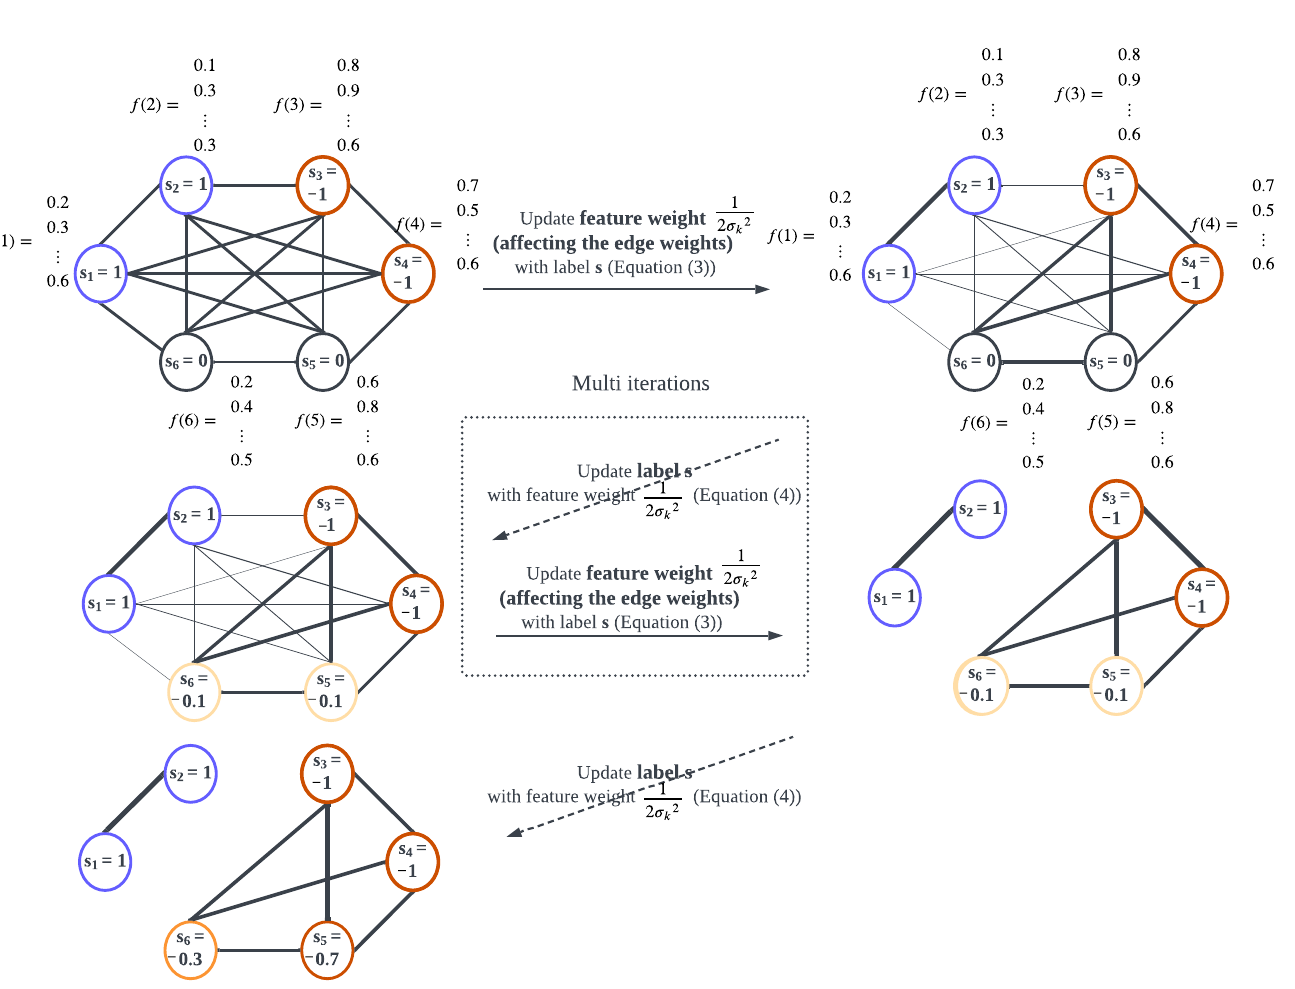
Figure 2. Graph-based feature weight optimisation and classification (schematic diagram), where the solid line represents Graph-based feature weight optimisation, and dashed line represents Graph- based